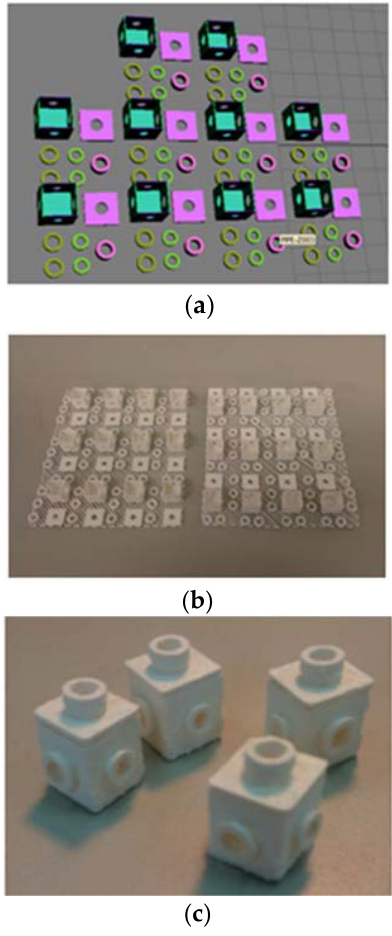
Figure 23. ( a ) 3D diagram of single block structures (multiple elements were produced simultaneously by a 3D printer); ( b ) 3D ‐ printed block element components; ( c ) assembled block elements.